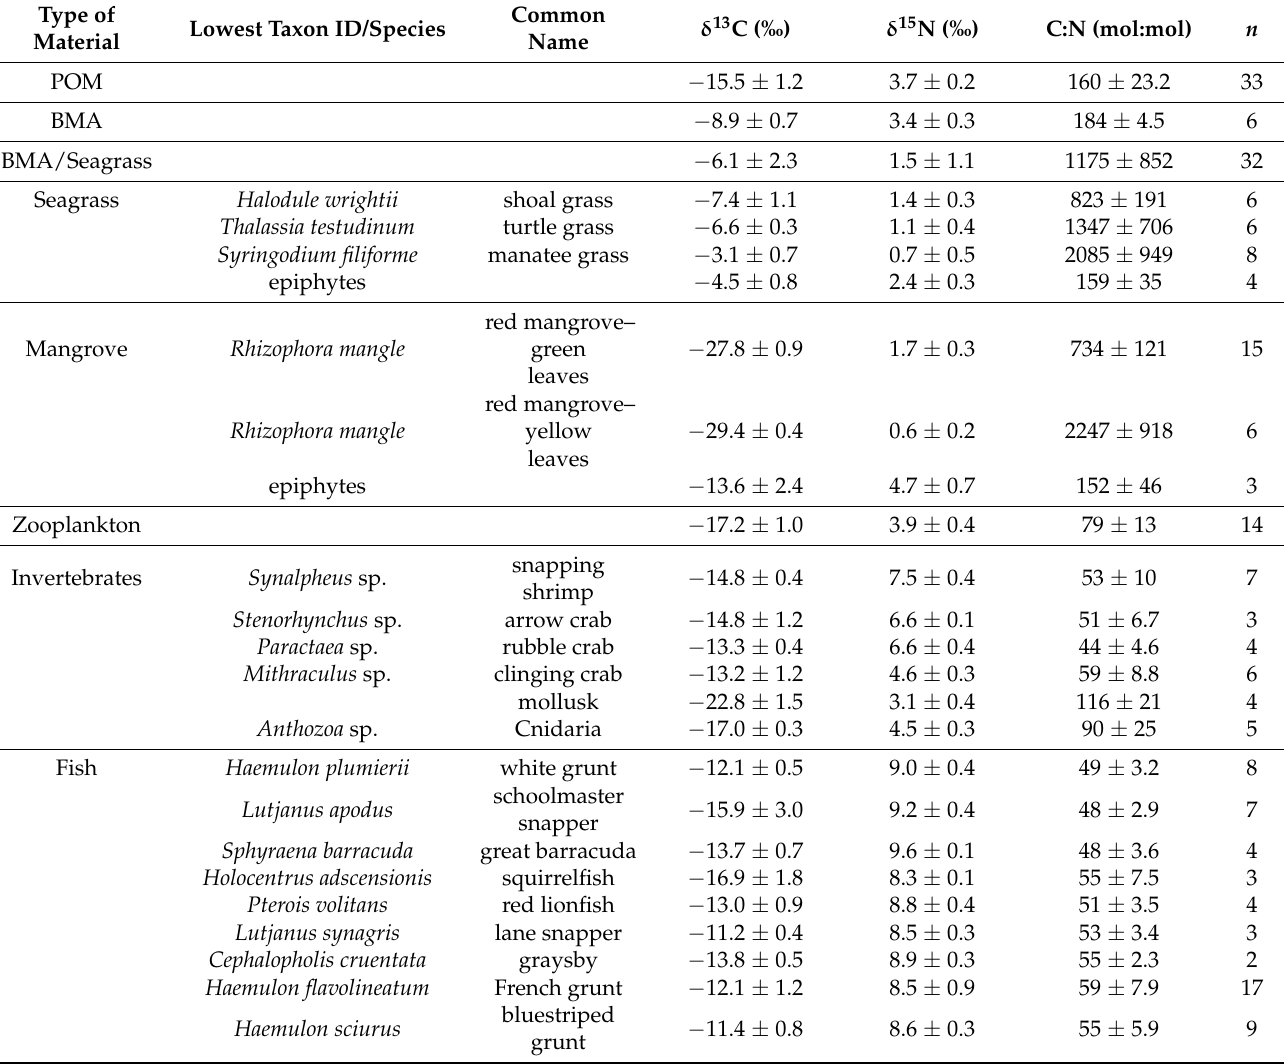
Table 1. Stable isotope values (means ± standard deviations) and C:N (mol:mol) ratios measured in the flora and fauna in the Gu á nica Biosphere Reserve. POM and zooplankton were collected from all around the reserve while all other samples including the BMA were taken from only within the MSP